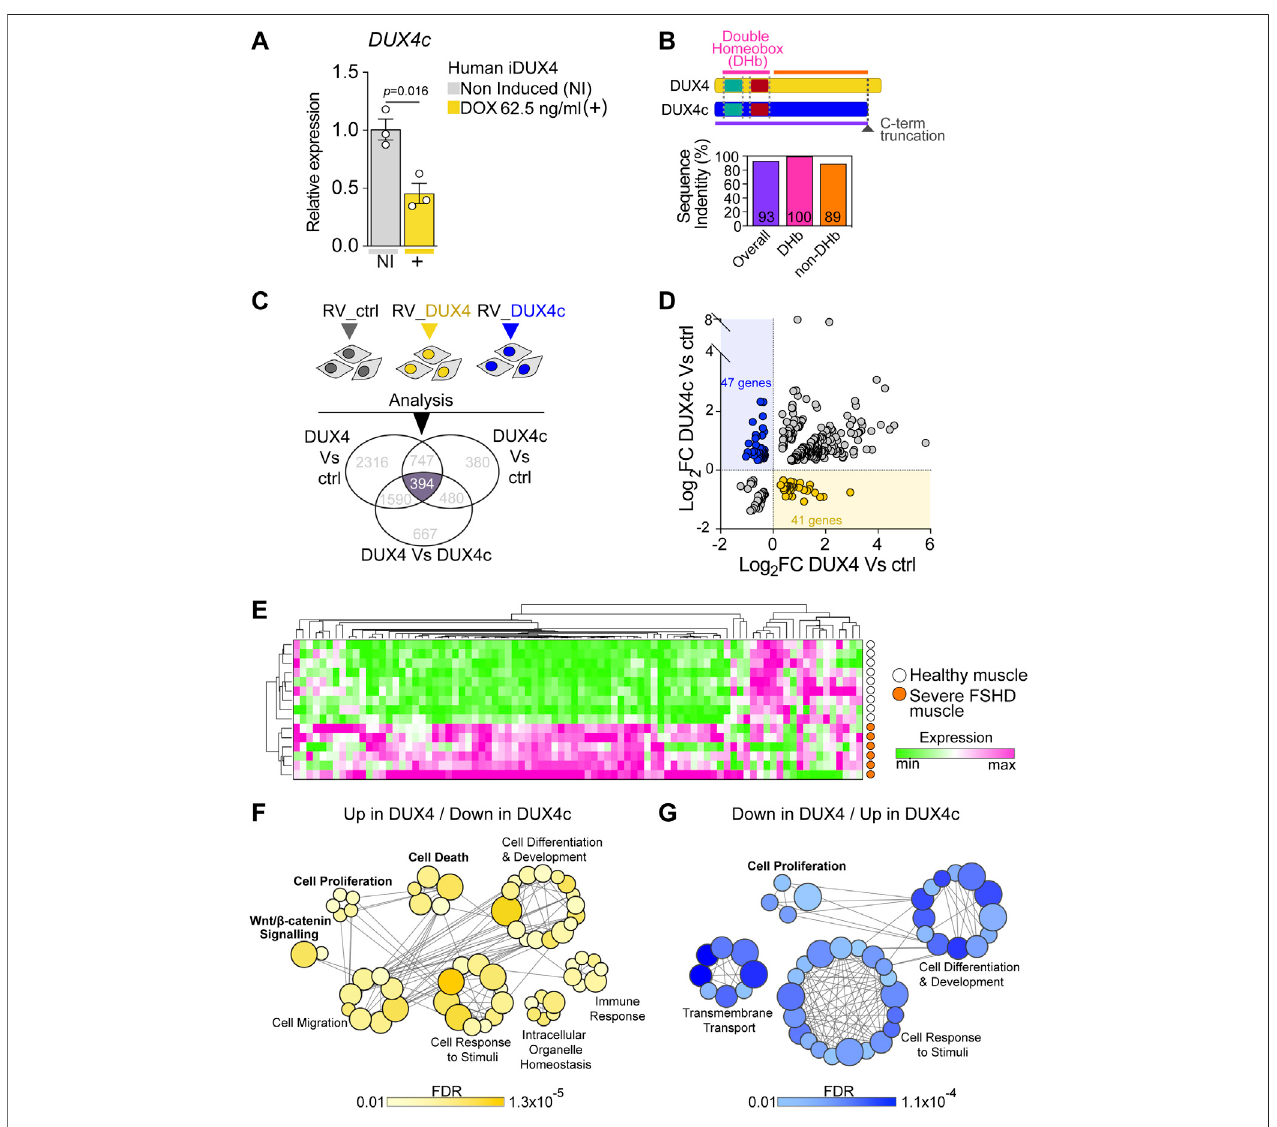
FIGURE 3 | DUX4 and DUX4c transcriptomes converge on cell homeostasis in FSHD. (A) RT-qPCR analysis on iDUX4 myoblasts when non-induced or after treatment with 62.5 ng/ml DOX (+) for 24 h showing down-regulation of DUX4c transcripts. Graph reports mean ± SEM, N = 3 biological replicates, unpaired two-tailed t-test. (B) Schematic of DUX4 and DUX4c proteins depicting the two identical homeobox domains and the C-terminal truncation (dashed dark grey line) in DUX4c compared to DUX4. Graph reports the amino acid sequence identity of DUX4 and DUX4c: either overall, just over the two homeobox domains (DHb), or the more C-term sequence (non-DHb). Percentage identity is reported within columns which are colour-coded with lines in the protein schematic above. (C) Venn diagram illustrating transcriptomic analysis of murine primary satellite cell-derived myoblasts transduced with human DUX4 (RV_DUX4), DUX4c (RV_DUX4c), or control retroviral vector(RV_ctrl)revealacommonsetof394differentiallyexpressedmouseprobes(referringto356humanorthologgenes).ExpressionvaluesretrievedfromGSE77100 Banerjiet al.(2015),Knoppet al.(2016). (D) Volcano plotdepictingthat88humanorthologgenesdisplayoppositeregulationbyDUX4andDUX4cinmurinemyoblasts. 41/356 are up-regulated by DUX4/down-regulated by DUX4c (yellow dots) while 47/356 are down-regulated by DUX4/up-regulated by DUX4c (blue dots). (E) . Expressionofthese88genesissuf fi cienttoseparatesevere(group4)humanFSHD( n =6,orange)andhealthymuscle( n =9,white)biopsiesuponhierarchicalclustering analysis. Expression values retrieved from GSE115650 (Wang et al., 2019). (F) Gene Ontology (GO) analysis retrieved by the subset of 41 target genes up-regulated by DUX4/down-regulated by DUX4c. (G) Gene Ontology (GO) analysis retrieved by the subset of 47 target genes down-regulated by DUX4/up-regulated by DUX4c. Main biological processes enriched by either subset are indicated with bubbles representing speci fi c GOs, coloured based on False Discovery Rate (FDR) values, and size proportional to number of genes within speci fi c GO terms, grey lines represent genes shared across different GOs.